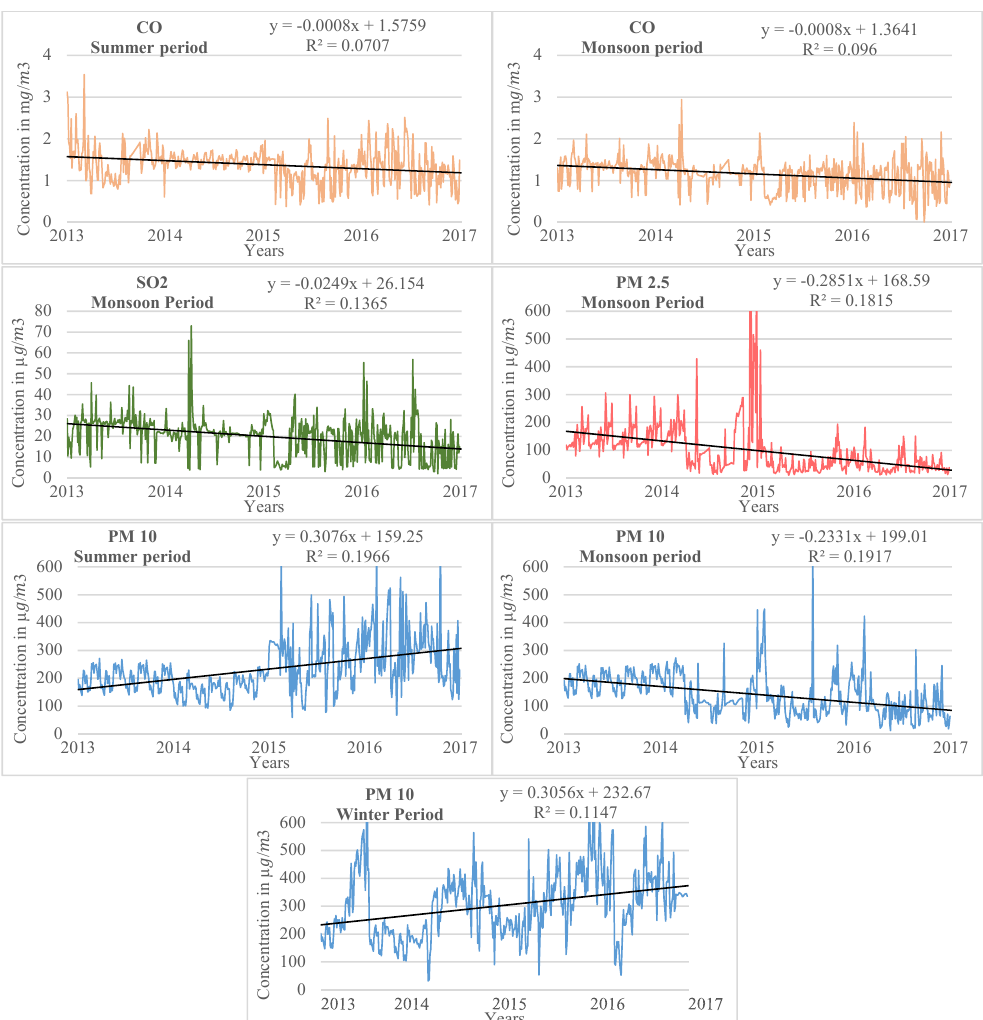
Fig. 2: Seasonal trend graph of different pollutants for the period from year 2013 to 2016